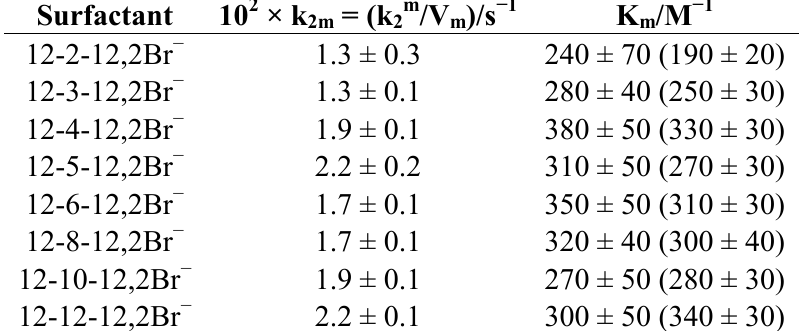
Table 2. Values of the adjustable parameters obtained from the fittings of the experimental kinetic data corresponding to the reaction 2-( p -nitrophenyl)ethyl bromide, PEB, + Br − in several dimeric micellar solutions by using Equation (1). T = 303